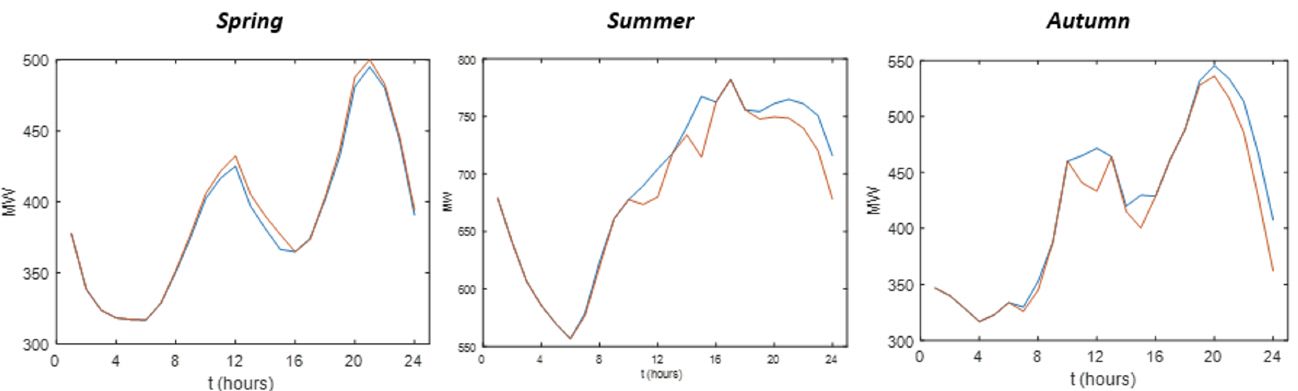
Figure 15. Real-time deviations from the day-ahead forecast concerning specific, energy-intensive days in spring, summer and